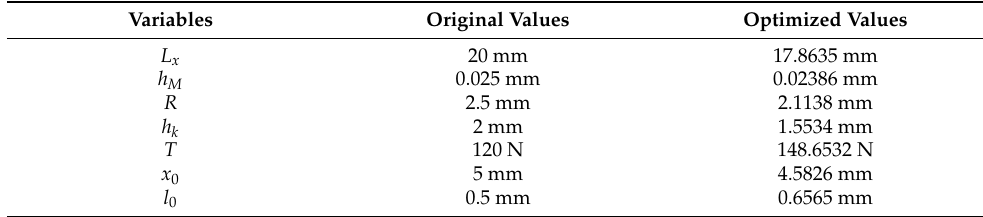
Figure 17. Comparison of the original and optimized MAMs for the STL curve. Table 2. Original and optimized design variable